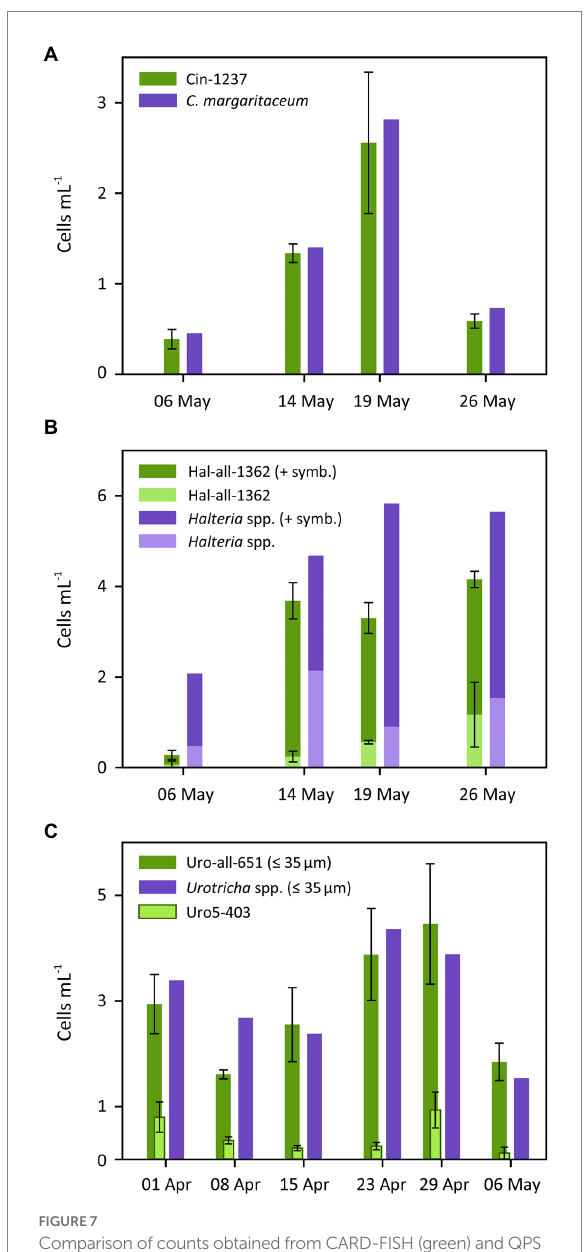
FIGURE 7 Comparison of counts obtained from CARD-FISH (green) and QPS (violet) preparations from water samples collected in Lake Zurich during spring 2020. Cells hybridized with C. margaritaceum -probe Cin-1237 (CARD-FISH) compared to protargol-stained C. margaritaceum (QPS, A ), cells hybridized with genus-specific Halteria -probe Hal-all-1362 compared to Halteria spp. from QPS, quantified with and without algal symbionts (dark and light color, respectively, B ), and hybridization with Uro-all-651-probe for Urotricha spp. compared with Urotricha spp. from QPS (C) . Lake water samples were additionally hybridized with Uro5-403 to look for U. cf. pseudofurcata (light green bars in C ). Error bars show standard deviations. Note that no replicate was available for QPS